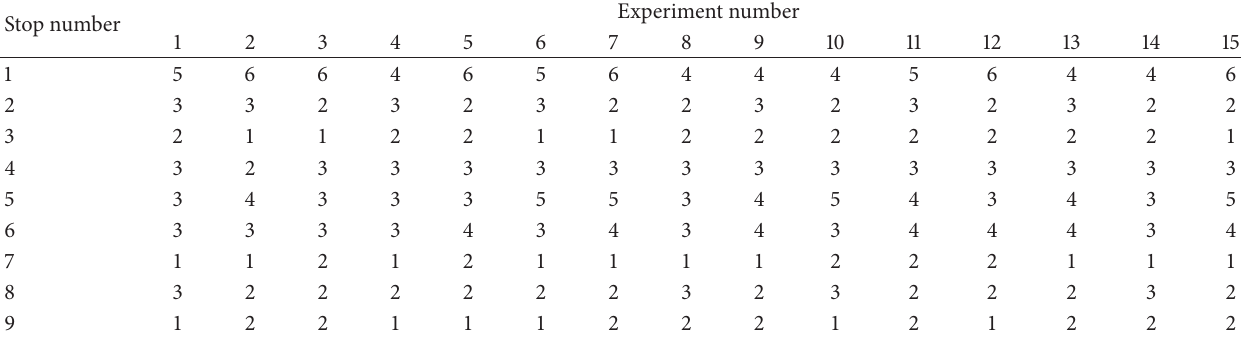
Table 5: Information on the number of incoming passengers.